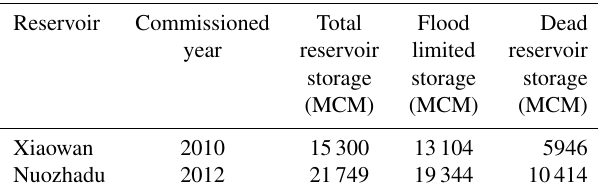
Table 1. Reservoir information of Xiaowan and